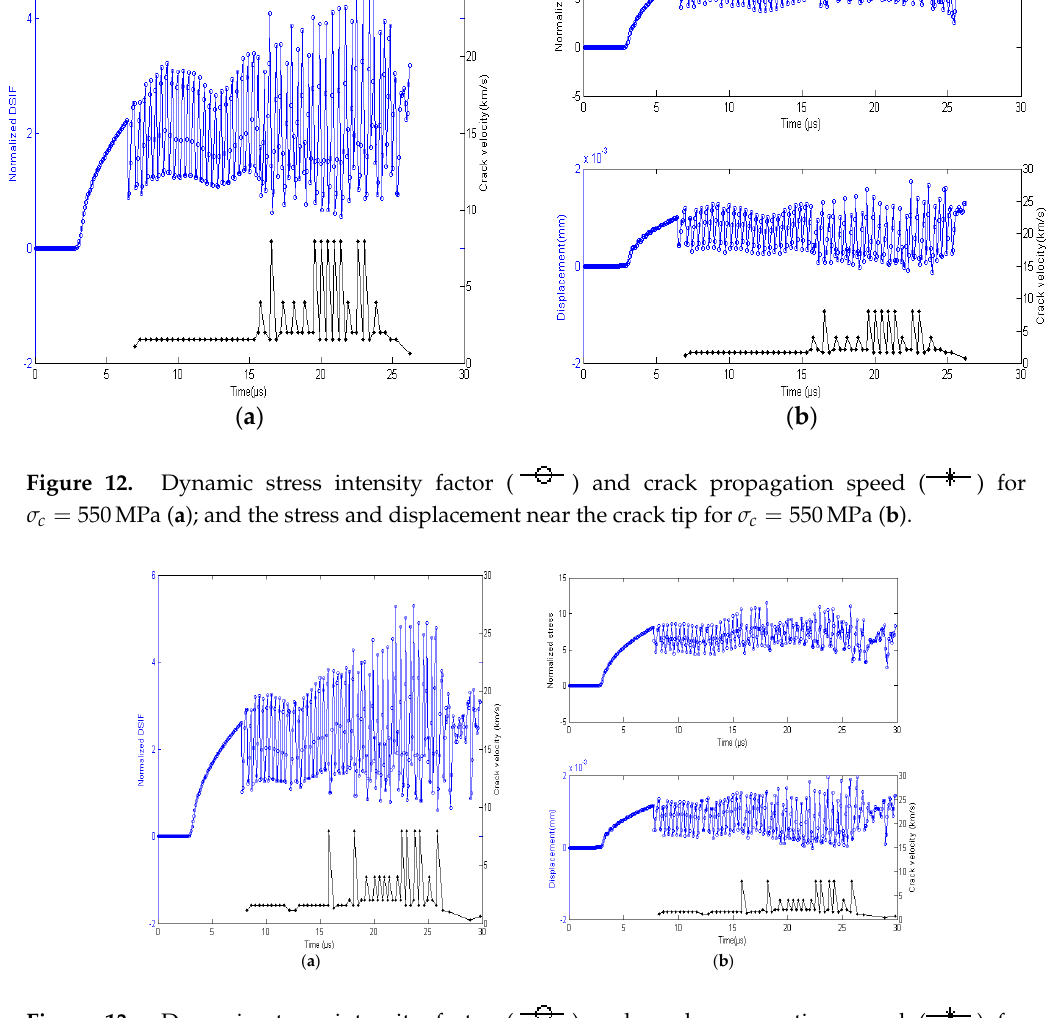
= σ ( b ). Figure 13. Dynamic stress intensity factor ( Figure 11. Dynamic stress intensity factor ( ) and crack propagation speed ( ) for ) c